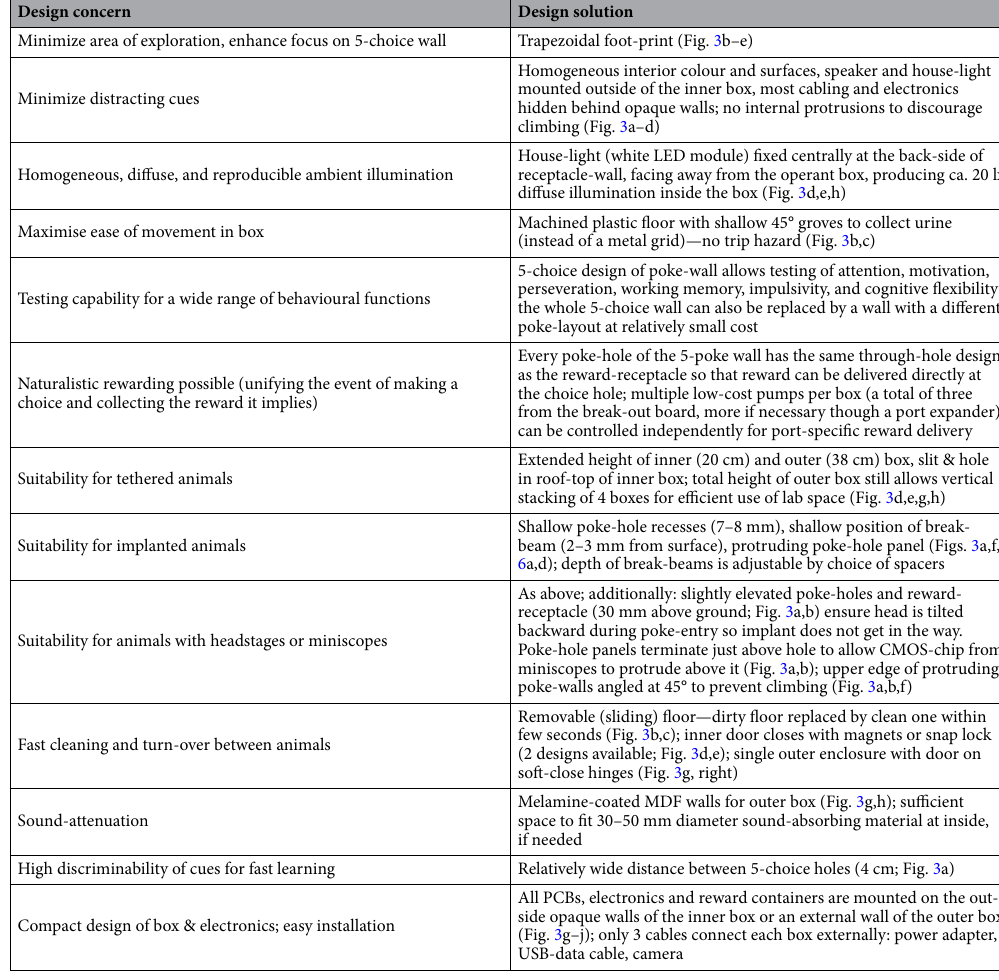
Table 1. Design considerations for inner and outer